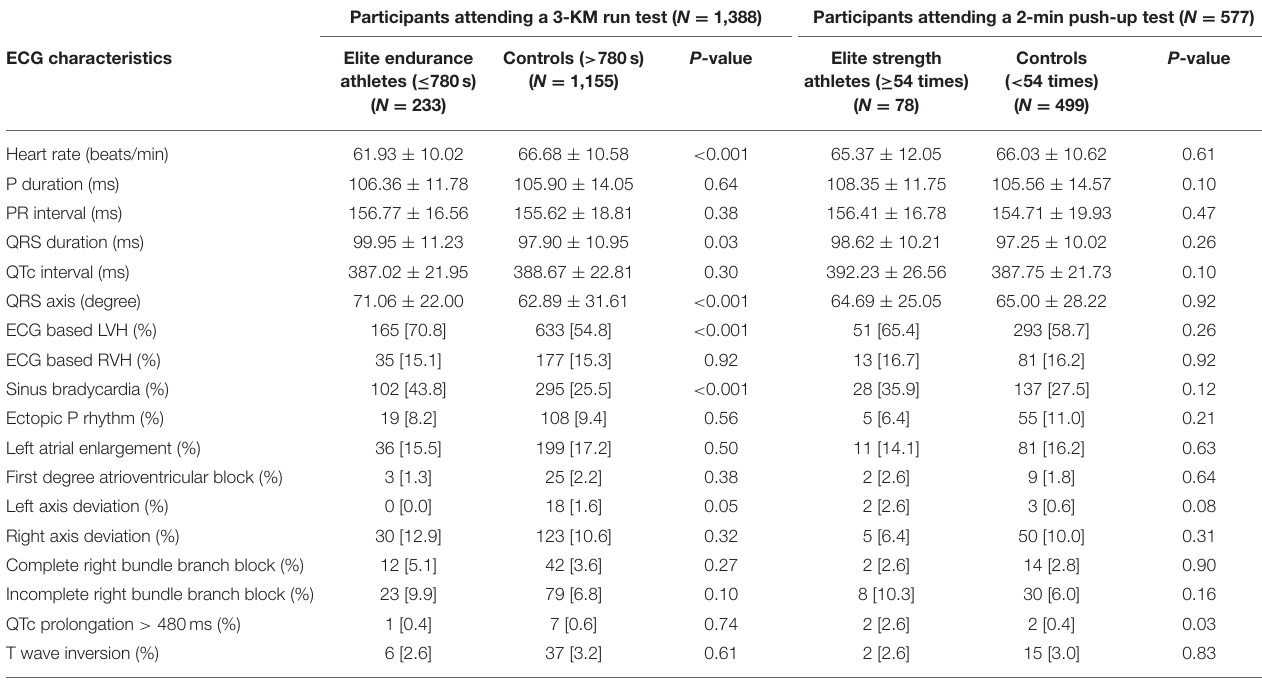
TABLE 2 | Electrocardiographic characteristics of elite endurance and strength athletes and non-elite